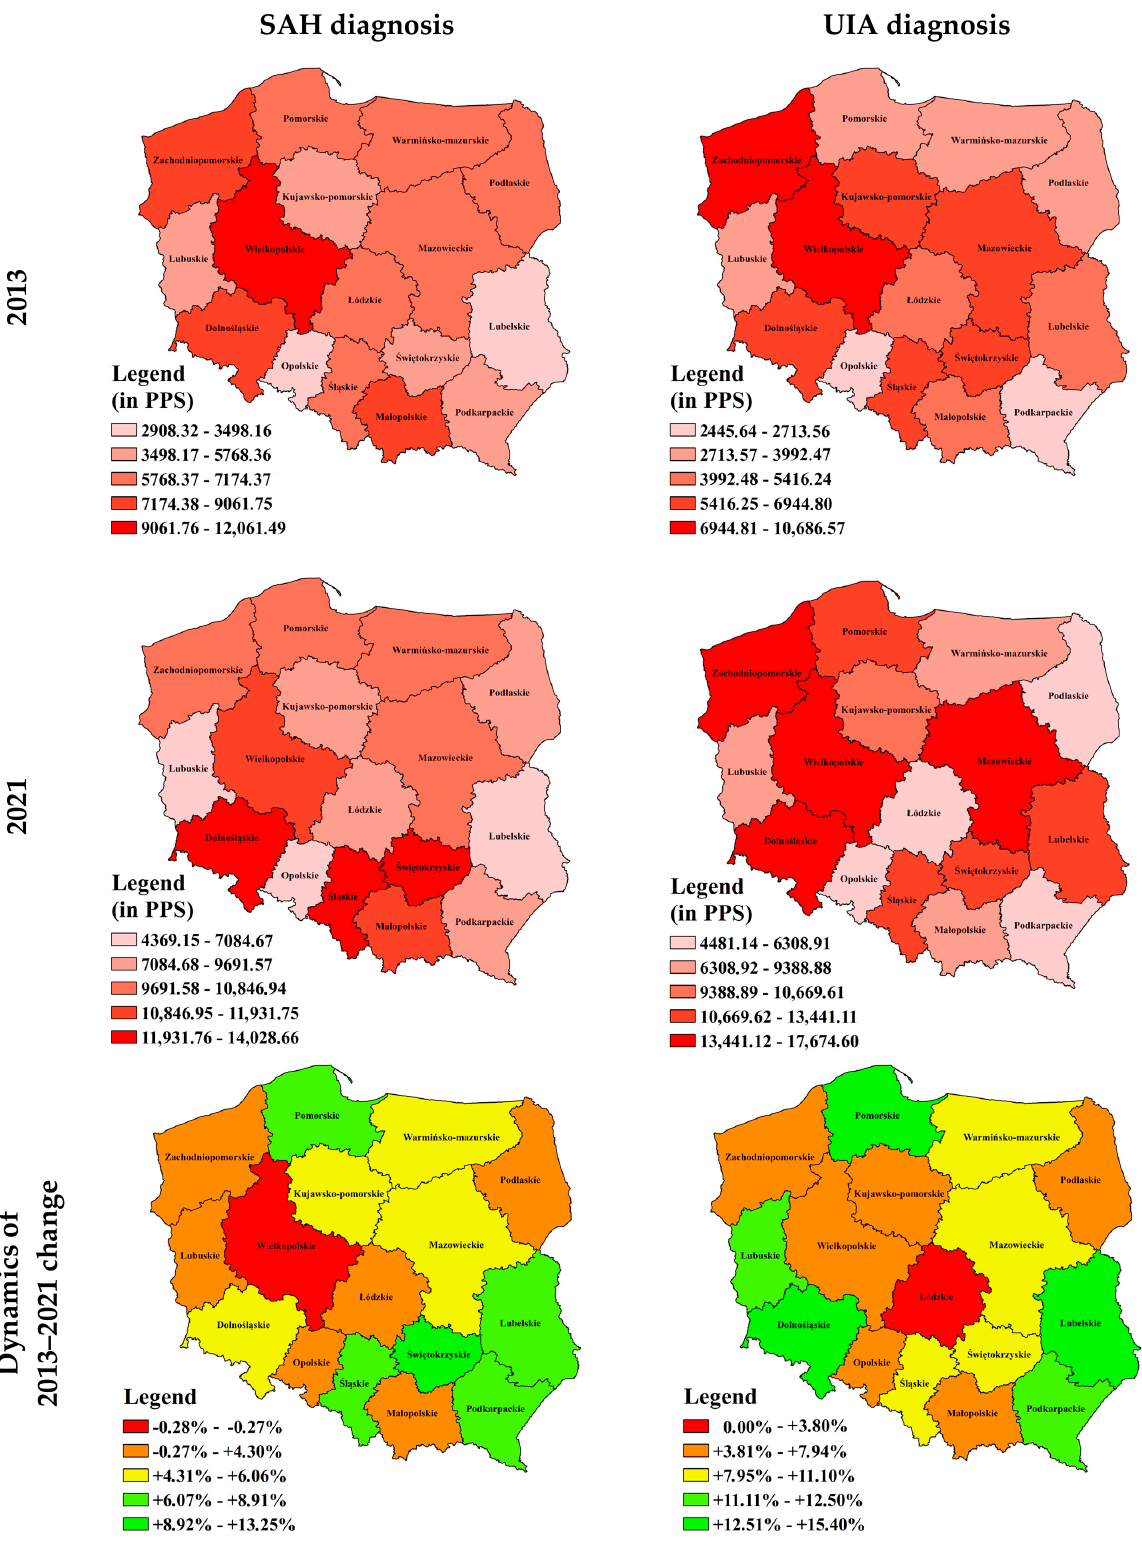
Figure A1. The value of services paid per patient in 2013 and 2021. Table A2. Changes in the levels of reported services per patient by value in PLN (PLN) for provinces in the years 2013–2021 in total and for SAH and UIA diagnoses.